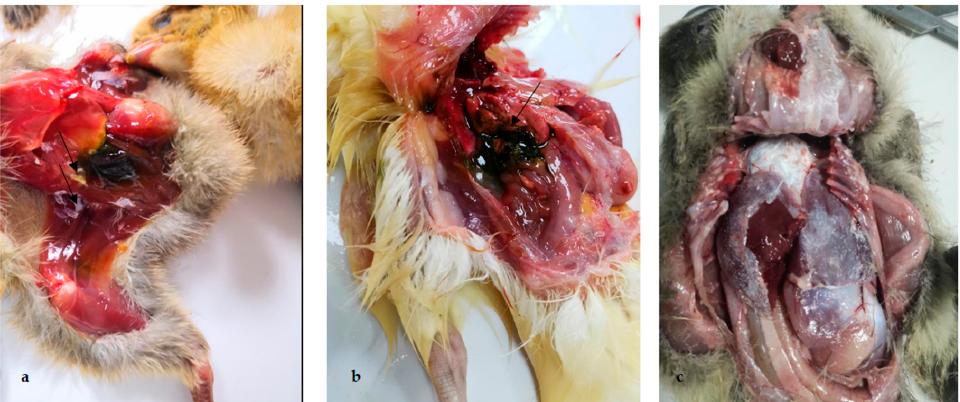
Figure 2. Pathological lesions of clinical samples of chickens, ducklings and goslings affected with gout. ( a ) Urate deposition on the peritoneum and between legs and abdomen of chicken; ( b ) urate deposition in the gallbladder of duckling; ( c ) urate deposits on pericardium and peritoneum of gosling.